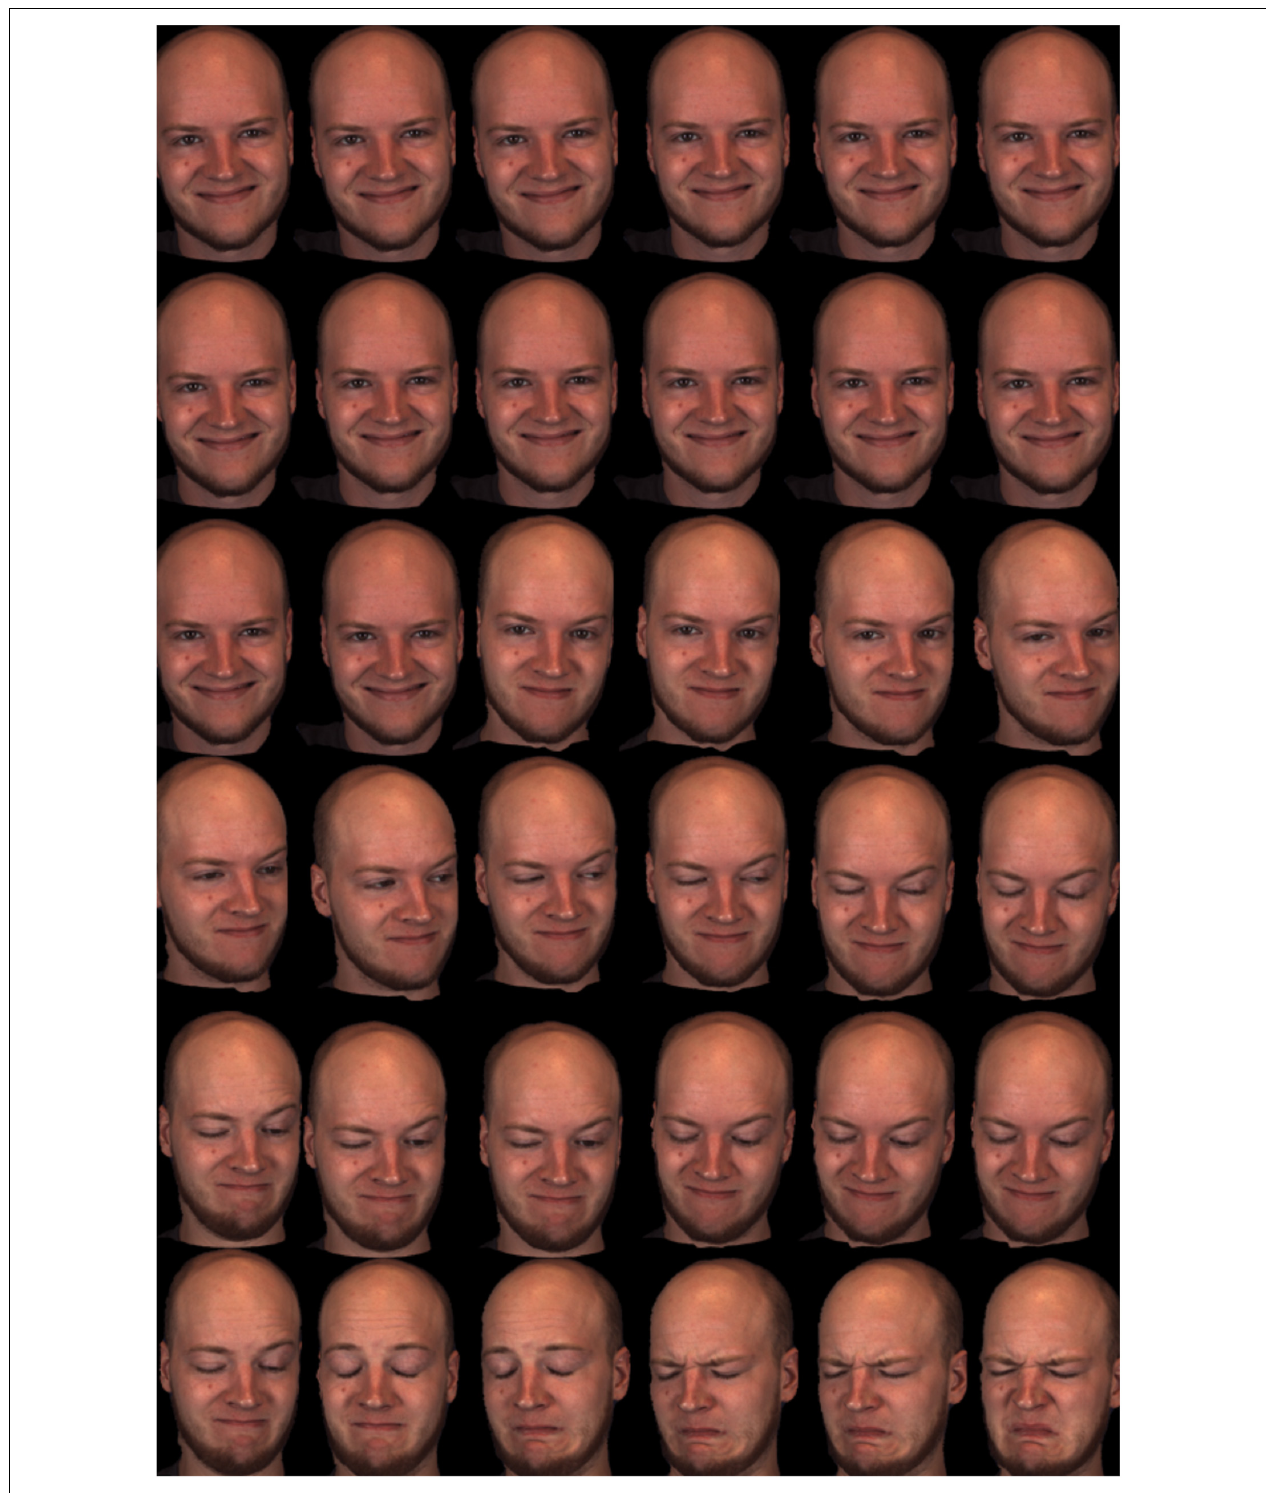
FIGURE 7 | Video-recorded dynamic 4D facial stimulus captured as still frame-by-frame images, displaying happy and disgusted FACS coded emotion (The images pictured above were reproduced, modified and adapted from the facial database originally developed by Zhang et al. (2013, 2014). Copyright 2013–2017, The Research Foundation for the State University of New York and University of Pittsburgh of the Commonwealth System of Higher Education. All Right Reserved. BP4D-Spontaneous Database, as of: 26/03/2018. This exemplar presents the frame-by-frame stills from a video-recording of a 4D face, moving from a happy expression to a disgusted